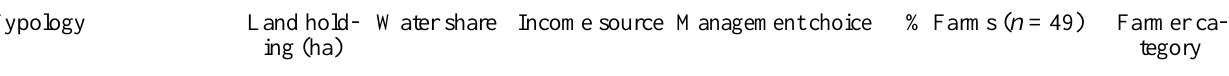
Table 1. Share of irrigation water used by different farm types in two villages of the Lingmuteychu